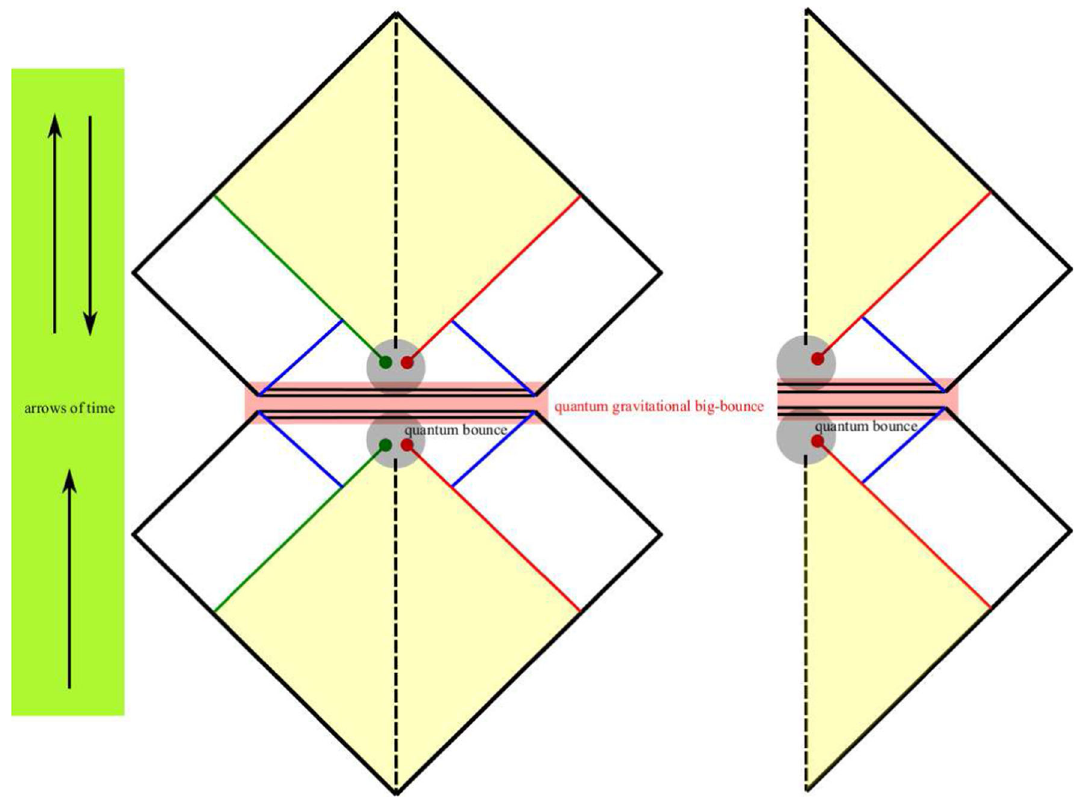
Fig. 9 If there is any principle to explain a quantum big-bounce near the singularity, one can accordingly explain the destination of the collapsing shell the spacetime has a negative y and the spacetime bounces to the white hole